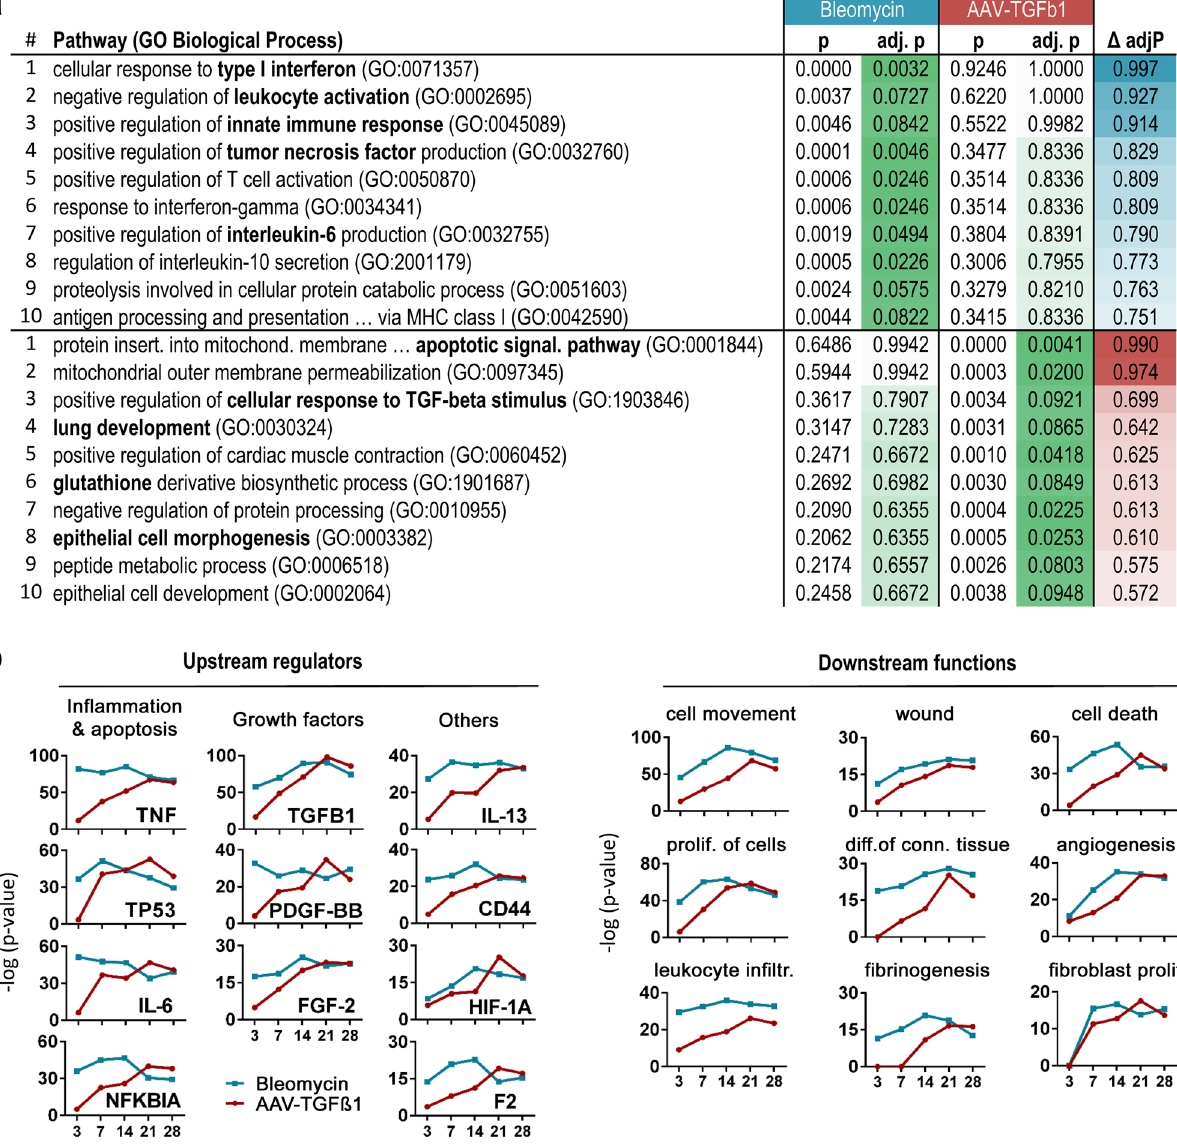
Figure 3. Differentially activated pathways and upstream regulator prediction. ( a ) Shown are the top 10 pathways preferentially enriched in the respective model, defined and ranked by the difference in pathway enrichment score (Δ adj. p ) between the models. Color shades from dark to light green visually highlight p -values. ( b ) Selected, categorized upstream regulators (left) and downstream functions (right) as predicted by Ingenuity Pathway Analysis for all differentially expressed genes per time